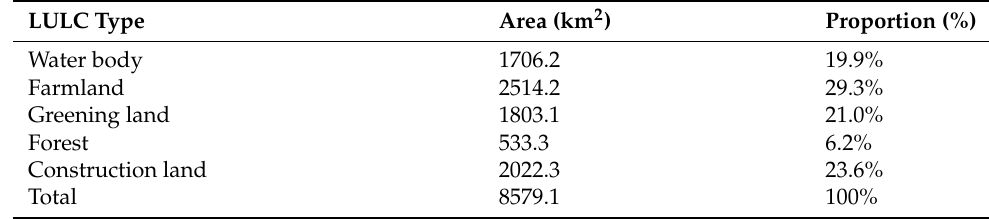
Figure 3. Spatial distribution maps of ( a ) LULC (Land use/Land cover), ( b ) NDVI (Normalized Difference Vegetation Index), ( c ) NDBI (Normalized Difference Built-up Index) and ( d ) NDWI (Normalized Difference Water Index) values. Table 1. Area statistics of different LULC (Land use/Land cover) categories in 2018 in